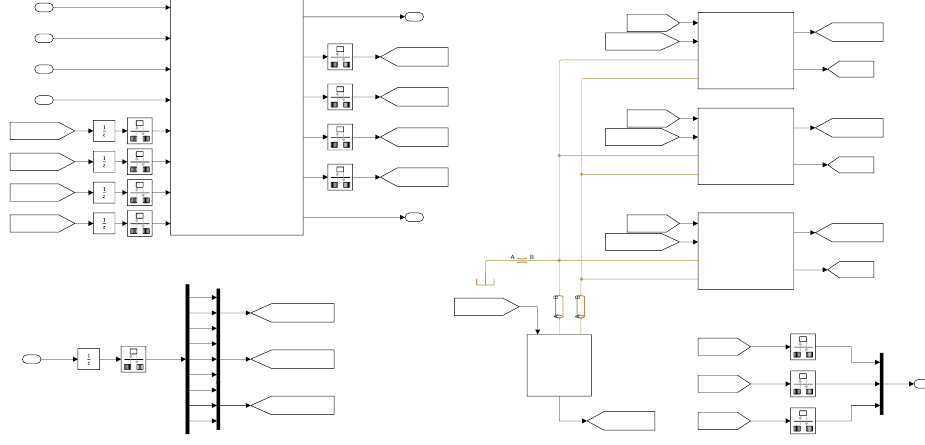
Figure 3. Hydraulic pitch system model, with control.